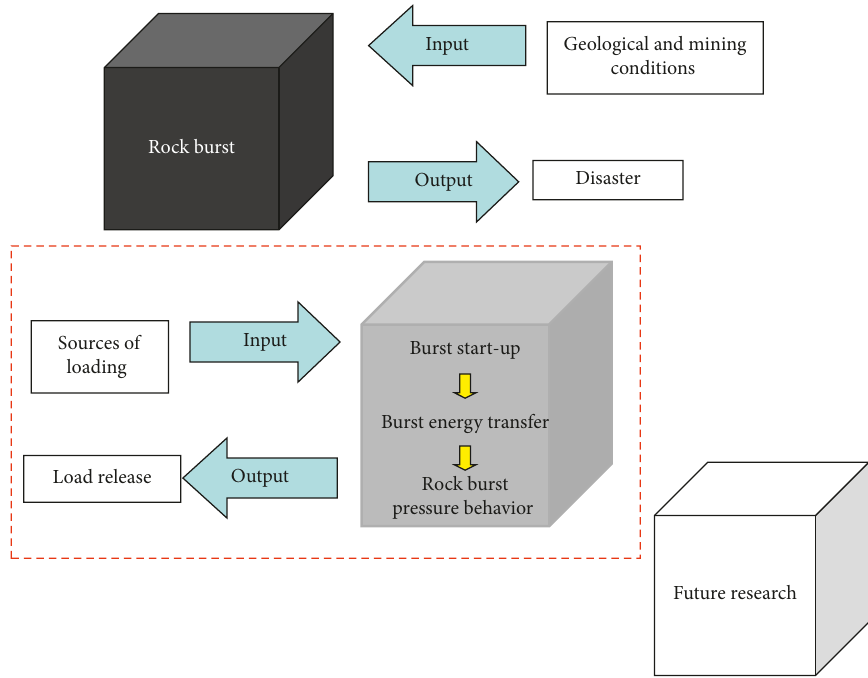
Figure 1: Black box understanding of the rockburst